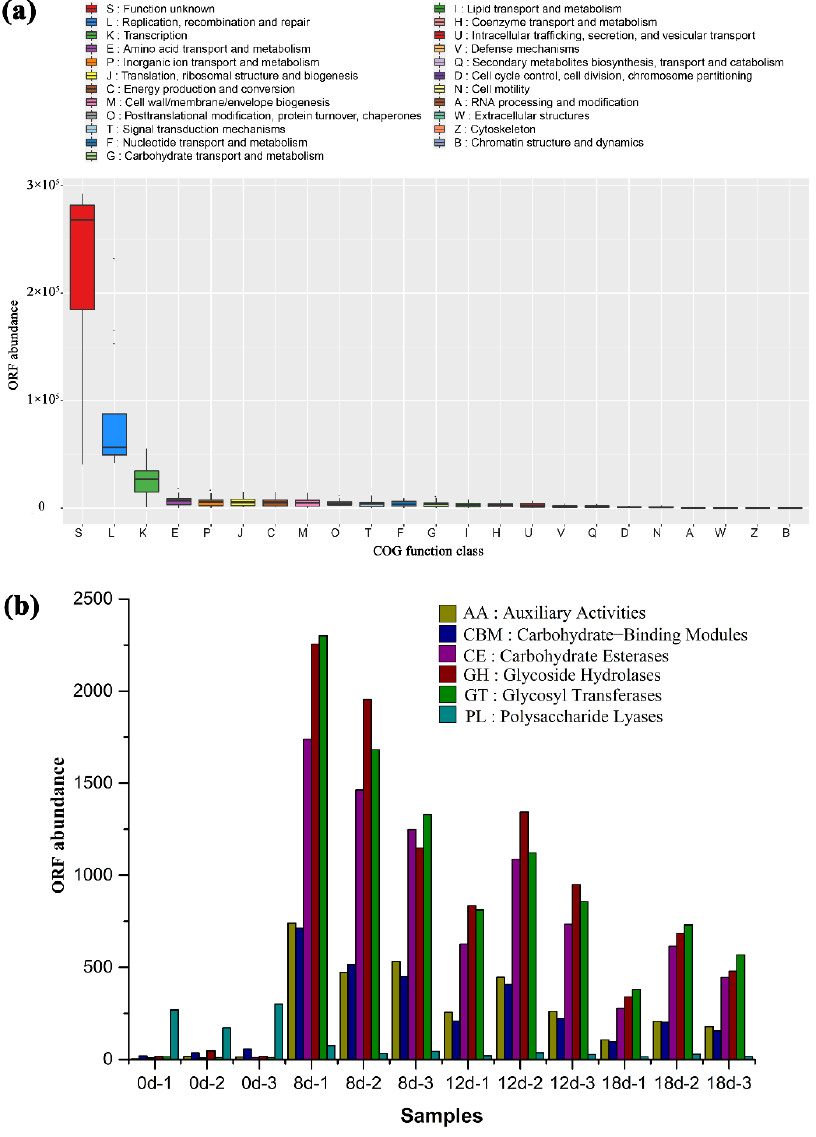
Figure 4. Abundant auxiliary carbohydrate-metabolism genes in vinegar Pei viruses. ( a ) COG functional annotation of vinegar Pei virome. ( b ) Annotation of viral carbohydrate-metabolism related ORFs in the CAZymes database.